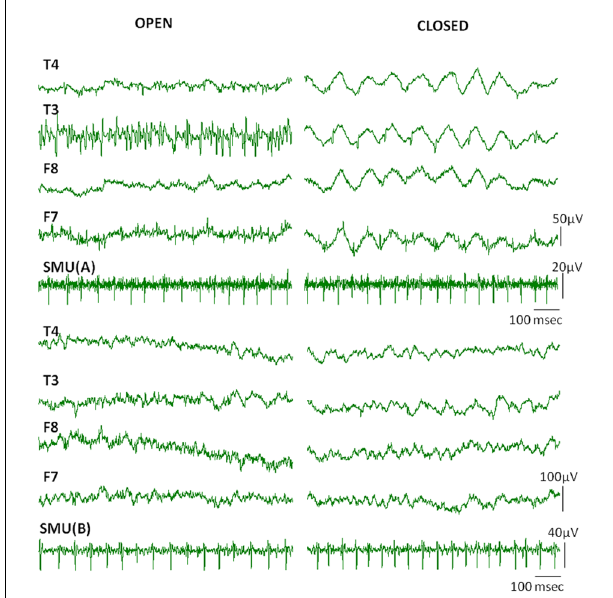
FIGURE 6 | Effect of closing the eye. Comparison of visible EMG interference on EEG channels when eyes are open (left) and closed (right) in a relaxed condition. The silencing effect of the eyes closed procedure is clearly seen in EEG but not in the SMU activity. This is because the muscles which ceased activity in eyes closed condition were not the ones from which the SMU activity was recorded.EEG electrodes F7, F8 and T3, T4 were located on anterior and medial temporalis respectively (Also refer to 1C for electrode names).